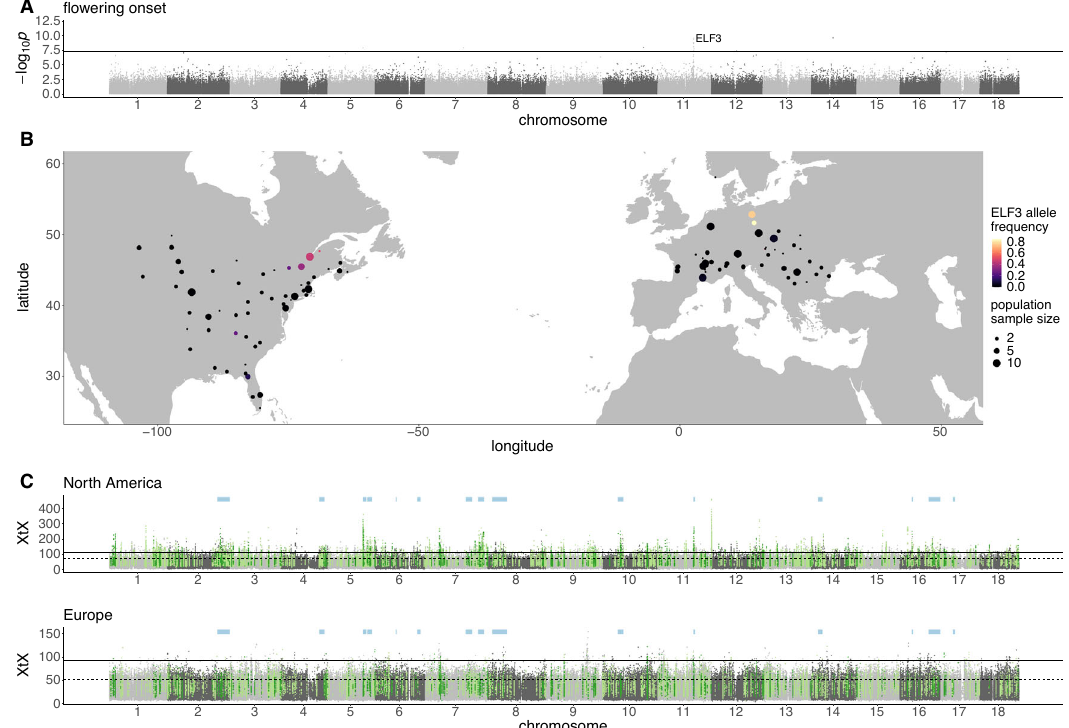
Fig. 2 | Signatures of climate adaptation in Ambrosia artemisiifolia . A GWAS − log 10 p -value of mixed model association against genomic location for onset(solidlineindicatesaBonferroni-corrected p -valueof0.05). B Distributionof astrongly-associatednon-synonymousSNPin ELF3 amongmodern A.artemisiifolia populations used in this study. C Genome-wide XtX scans between sampling locations within each range separately. Solid lines indicate Bonferroni-corrected signi fi cancederivedfromXtX p -values;dashedlinesindicatethetop1%ofgenome-